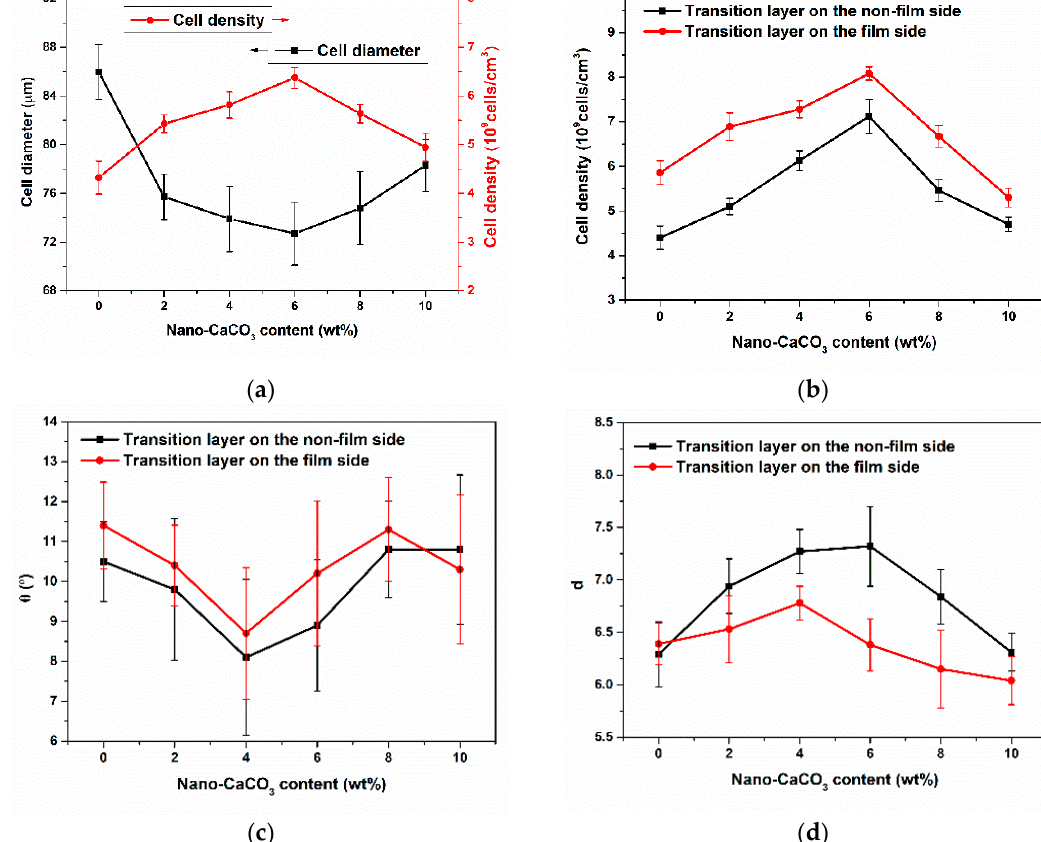
Figure 14. ( a ) Cell diameter and cell density of core layer; ( b ) cell density of transition layers; ( c ) cell tilt angle of transition layers; ( d ) cell ratio of length to diameter of transition layers.